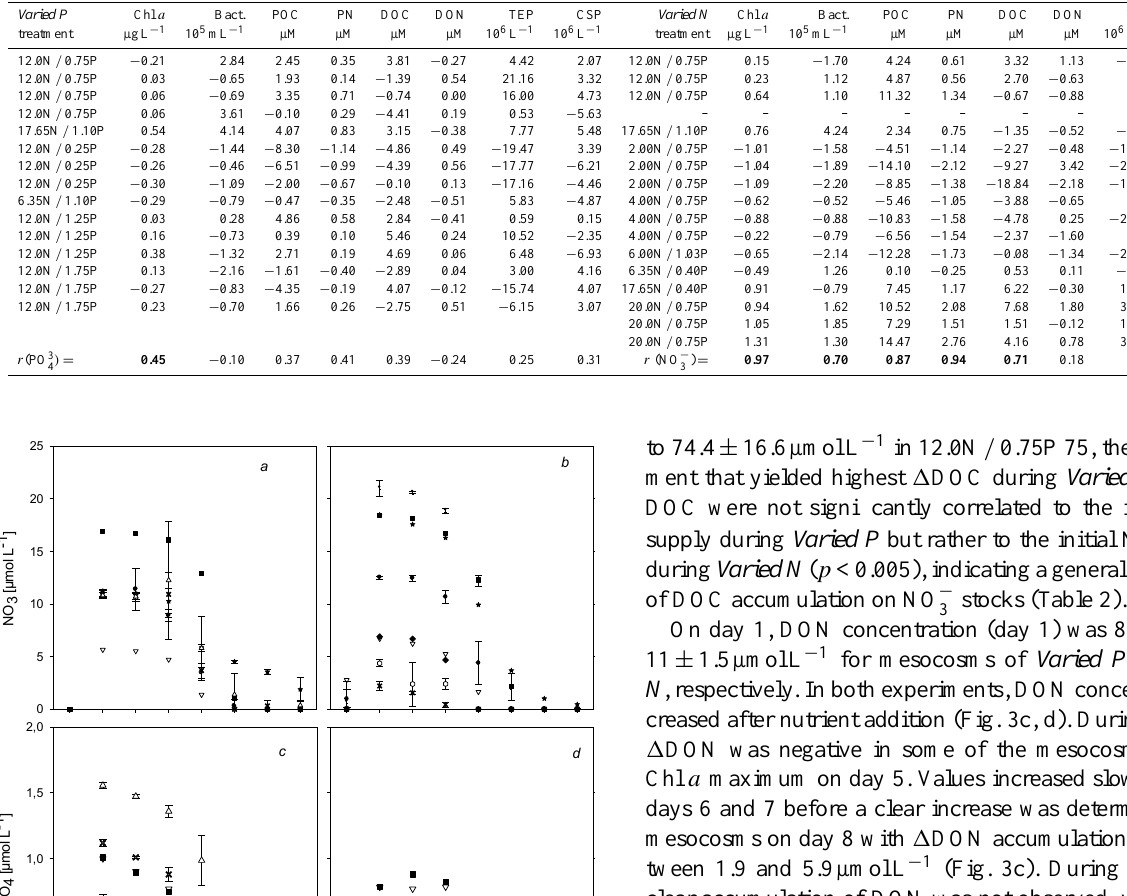
Table 2. Mean deviations (MDs) from the average development, averaged for each mesocosm for the full experimental period (day 1–8) and Pearson coefficients for correlations of MD versus initial PO 3 − numbers indicate significant correlation ( p <0.05).